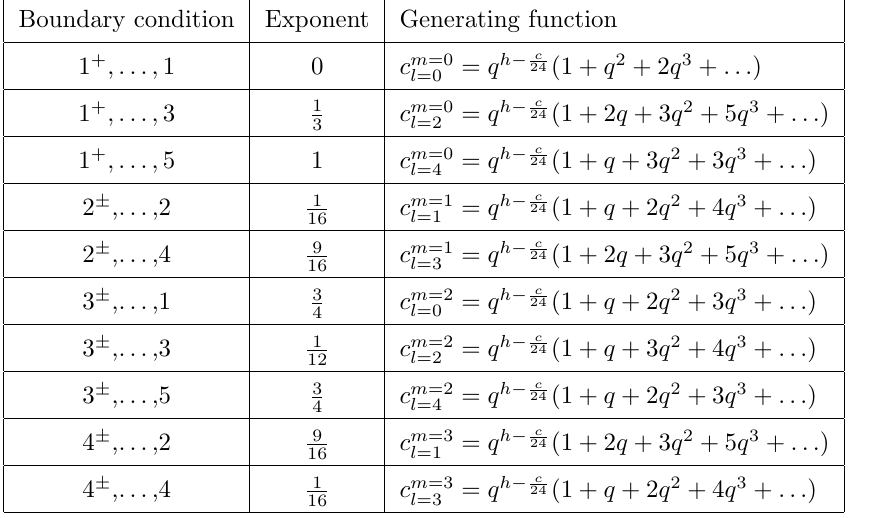
Table 2 . String functions in the k = 6 antiferromagnetic RSOS model. The string functions are expanded up to the terms we can clearly observe on the